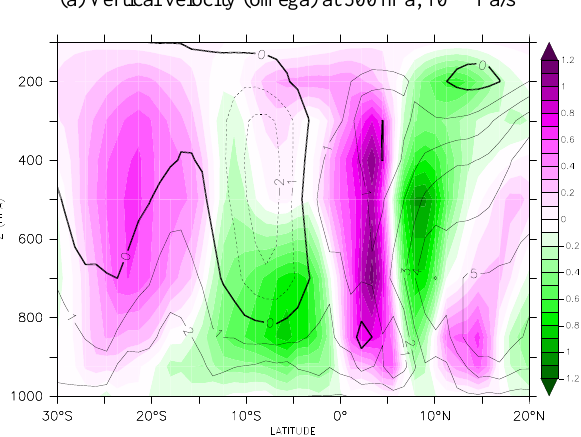
Fig. 15. Annual mean precipitation difference MH - PI over North Africa (20 ◦ W:30 ◦ E, land only). The thick black line is for EC-Earth, coloured lines are for PMIP2 ocean-atmosphere models. The colours and symbols are the same as in Braconnot et al. (2007a), Figure 10. See their Table 2 for model characteristics and references. Two additional models that are included here are: GISS modelE (green dashes, Schmidt et al. 2006) and CSIRO (red dashes, Gordon et al. 2000).